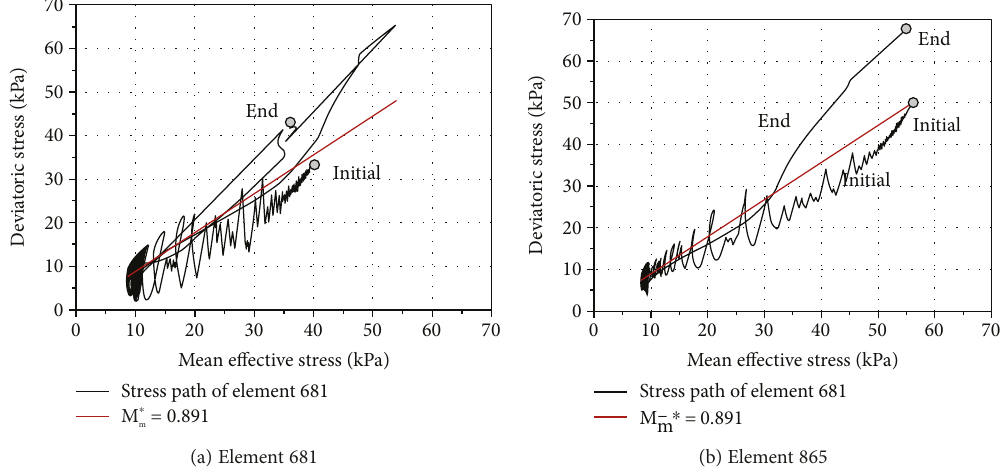
Figure 31: Stress paths for dynamic and reconsolidation analysis.